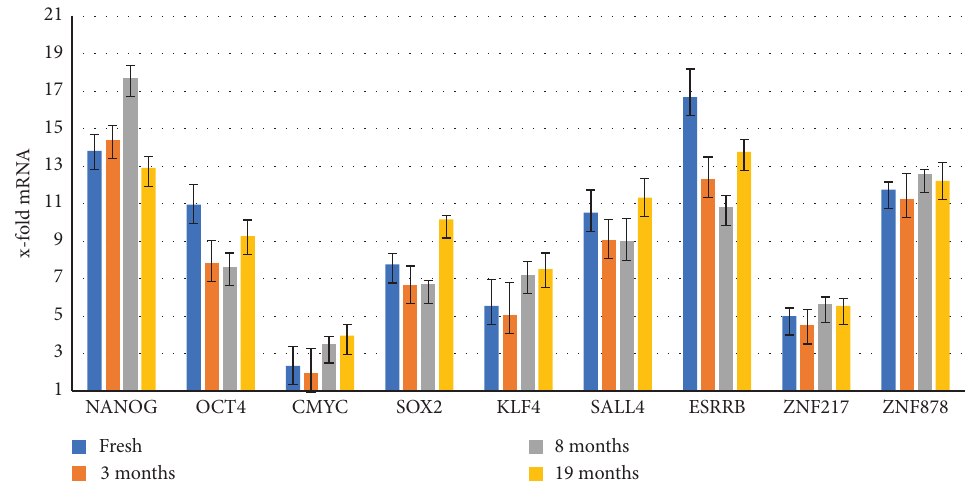
Figure 3: Immunophenotypic characterization of SCAPs before and after 3, 8, and 19 months of freezing reveals that no signifcant diferences present at surface markers expression percentages.